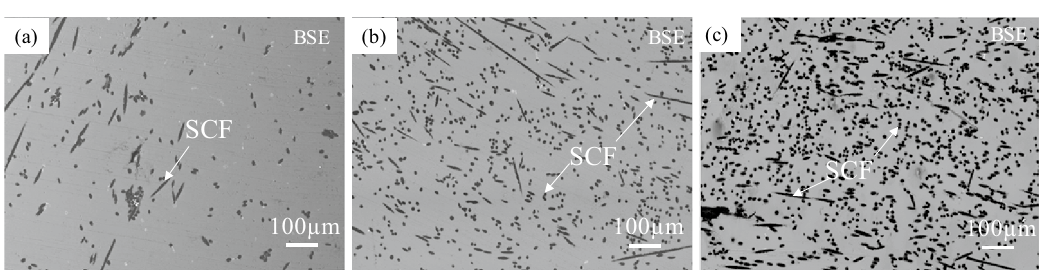
Figure 4. Microstructures of Cu-plated SCF/A1070 composites without preform manufacturing with different applied pressure under containing 7.1 vol% SCF: ( a ) 0.8 MPa, ( b ) 0.6 MPa, and ( c ) 0.4 MPa.